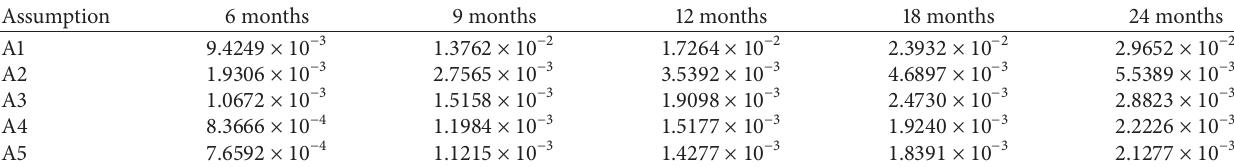
Table 1: RMSE with the different approaches for the 5000 simulated yield curves with 𝑁 = 7500 and Δ𝑡 = 1 / 250.